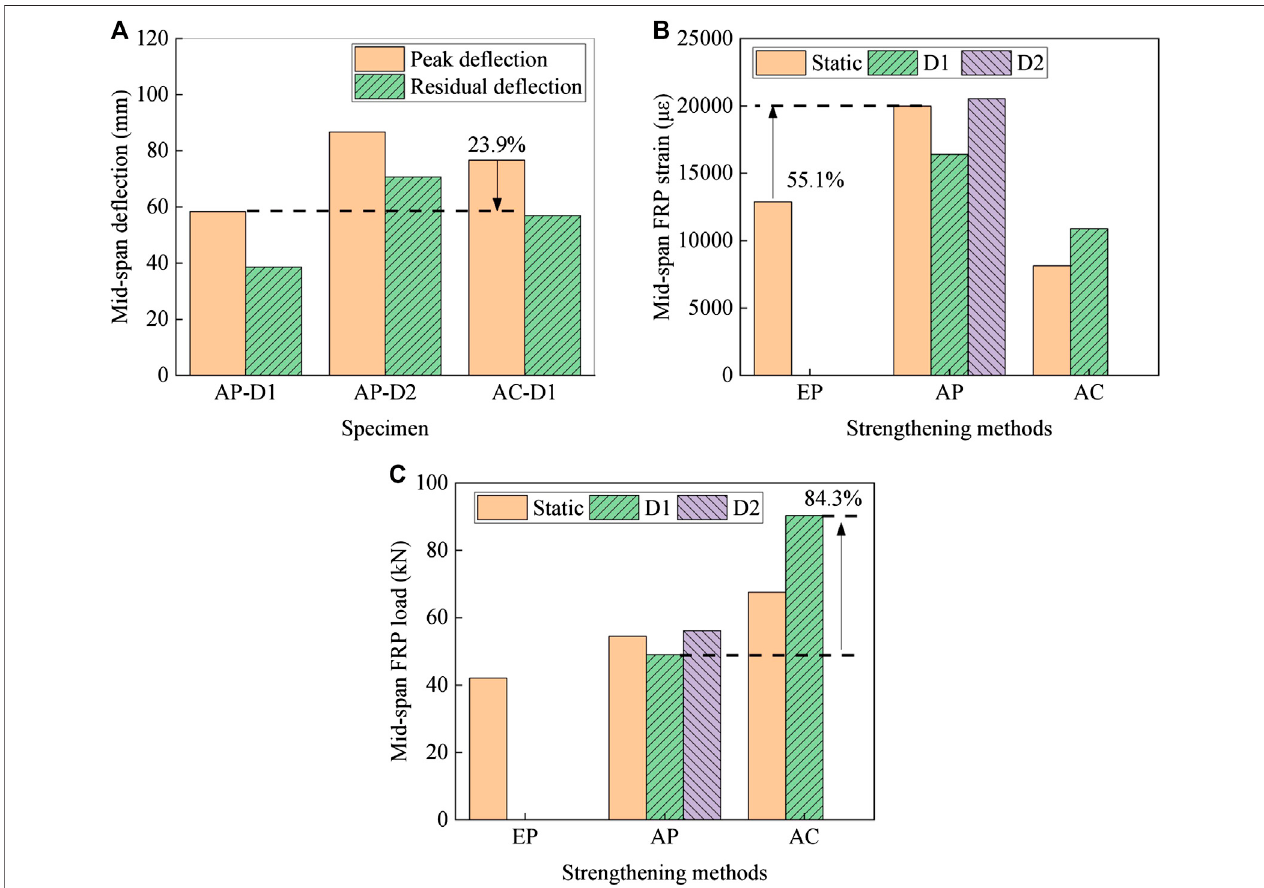
FIGURE 11 | Mid-span de fl ection and FRP strain analysis. (A) Maximum and residual mid-span de fl ections, (B) maximum mid-span FRP strain, (C) maximum tensile force in FRP laminate at mid-span.